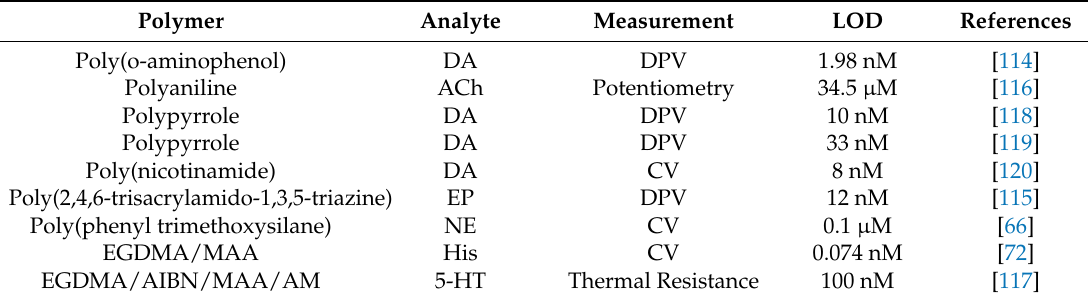
Table 6. MIP-based neurotransmitter